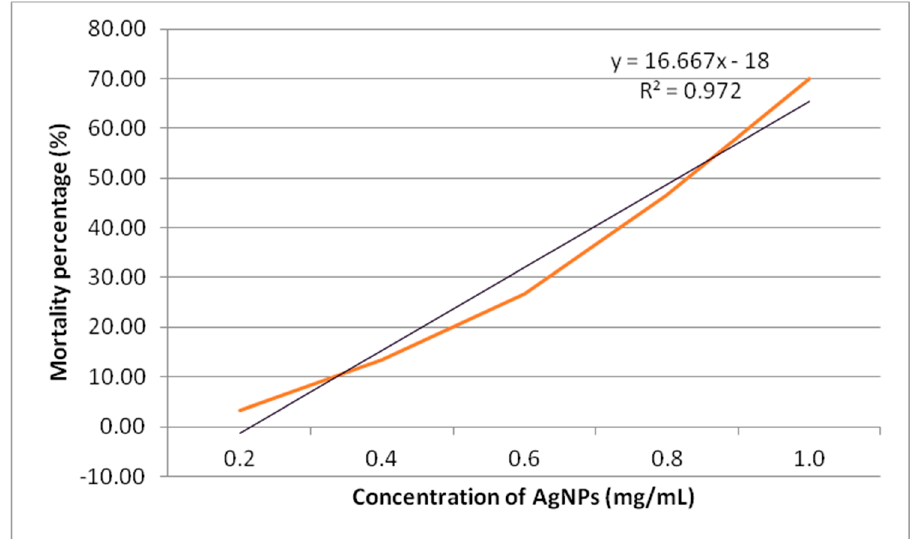
Figure 9. The cytotoxicity rate of synthesized AgNPs using A. salina.